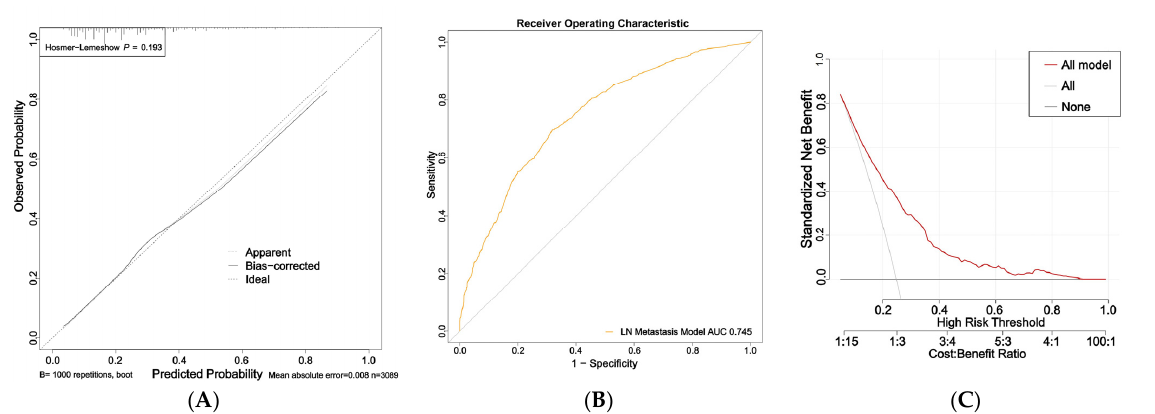
Figure 2. Calibration curves, area under the receiver operating characteristic curve (AUROC), and decision curve of the risk of nail involvement predictive nomogram: ( A ) Calibration curves of the risk of nail involvement predictive nomogram. The x ‐ axis represents the predicted risk of nail in ‐ volvement. The y ‐ axis represents the diagnosed nail involvement. The diagonal dotted line repre ‐ sents a perfect prediction of an ideal model. The solid line indicates the performance of the nomo ‐ gram, and the more consistent the dotted line, the better the prediction ability; ( B ) the AUC of the risk of PsA predictive nomogram. The AUC of the predictive model indicates the probability of accurately predicting whether the patient has nail involvement in a randomly selected case. The model exhibited good predictive power, and the AUC values of the whole sample (orange) are 0.745; ( C ) decision curve of the nomogram based on the risk prediction of patients with nail involvement. The y ‐ axis represents the net benefit. The red line indicates the nail ‐ involvement ‐ risk nomogram. The thin solid line represents the assumption that no patients have nail involvement. The gray line represents the assumption that all patients have nail involvement.